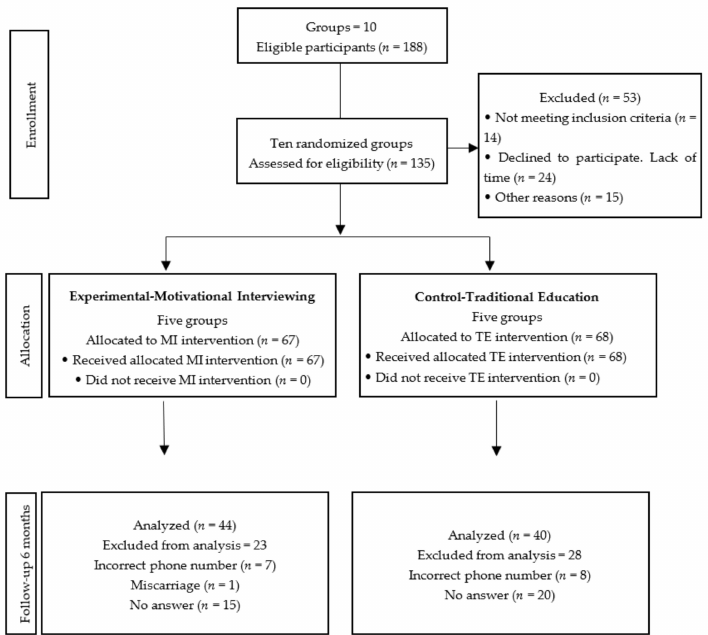
Figure 1. CONSORT flow diagram of assignment of participants from CAISES Le ó n, Guanajuato,